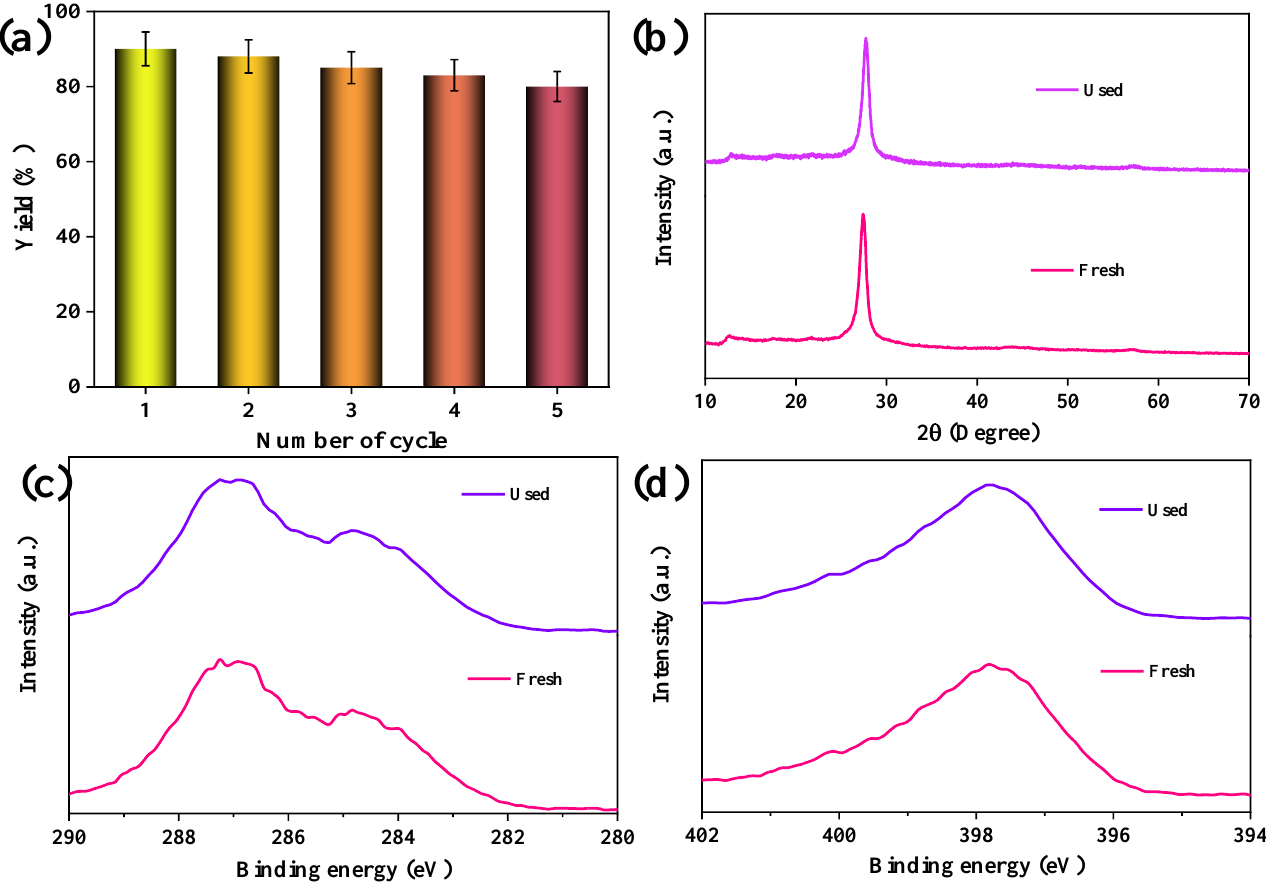
Figure 7. ( a ) Reusability of the 3CDCN photocatalyst and the stability of fresh and used 3CDCN, ( b ) XRD pattern, ( c ) XPS of C1s, and ( d ) XPS of N1s.